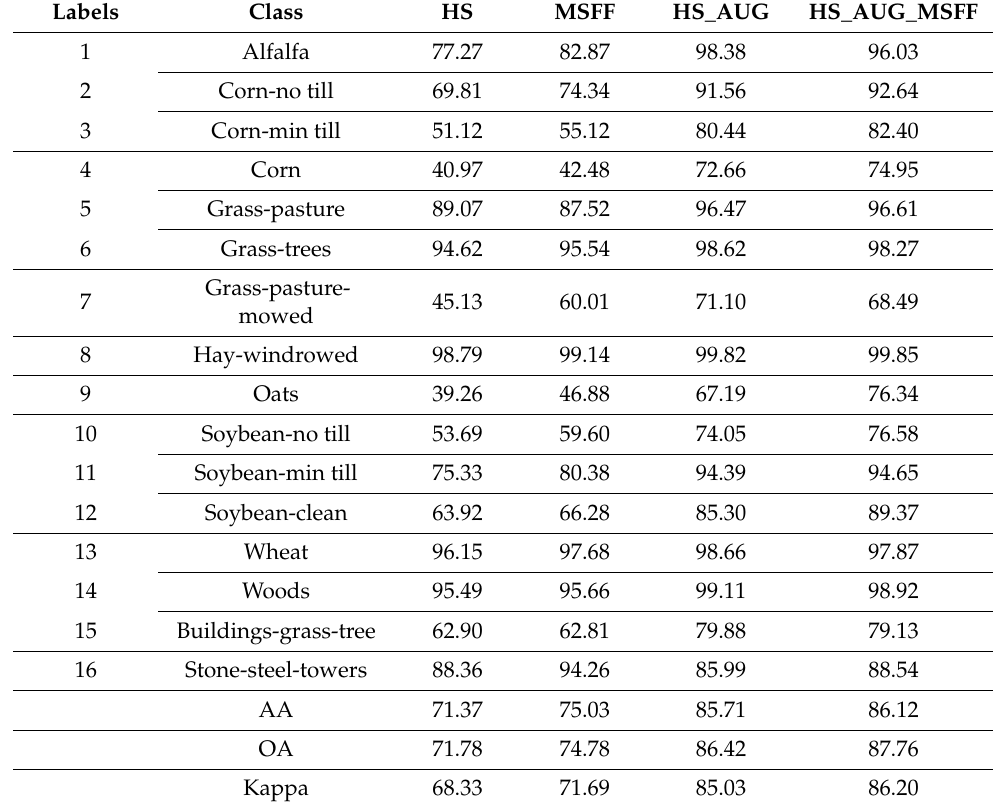
Table 1. Classification accuracies per class (%) for different features, by MLR on the Indian Pines data.